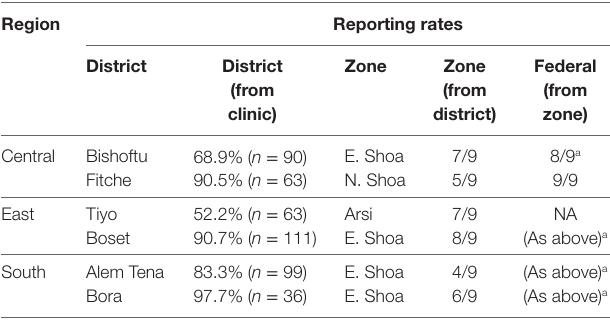
TaBle 5 | Proportion of returns at various levels of the reporting hierarchy ( n = number of possible reporting months for veterinary clinics/posts in a given unit) when using the traditional paper-based approach.